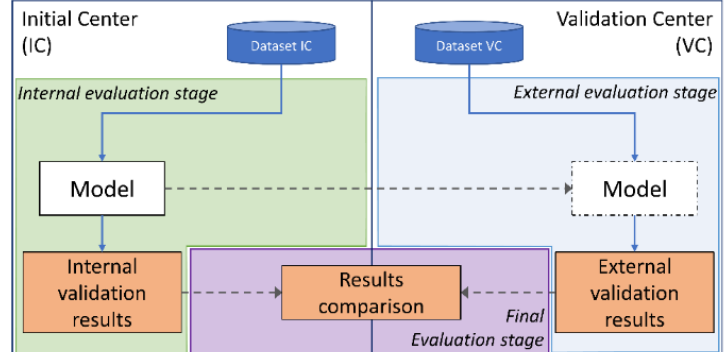
Figure 2. Diagram of the inter-center cross-validation. The entire exchange process is obtained by organizing a cross-validation protocol in three main stages, which requires the exchange of the models and their evaluation. Each model is validated on the initial center and on the validation center. Finally, a comparison between the internal validation and the external validation results is performed to evaluate the performance of each model on an unseen external center dataset.